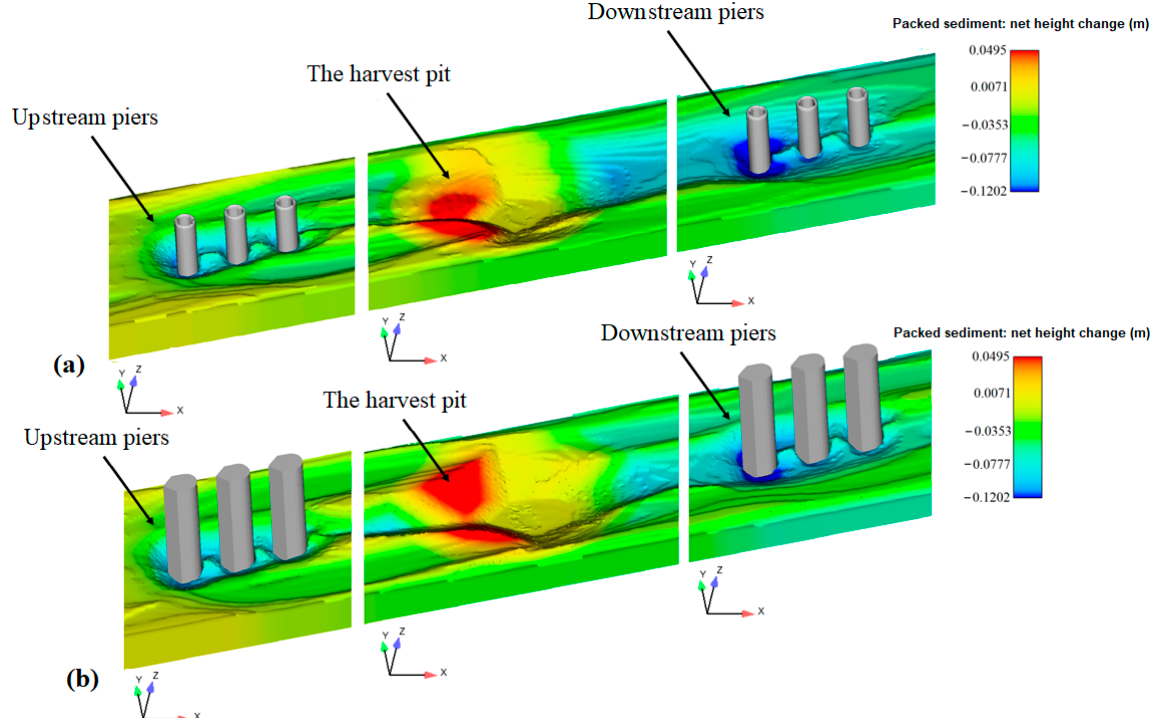
Figure 10. Bed elevation changes from around the group piles and the material harvest pit: ( a ) Circular model; ( b ) hydrodynamic model.